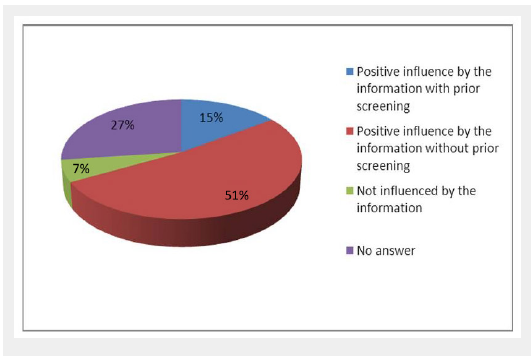
Impact of the “on-site prevention and education” concept regarding the incentive towards a regular cardiac